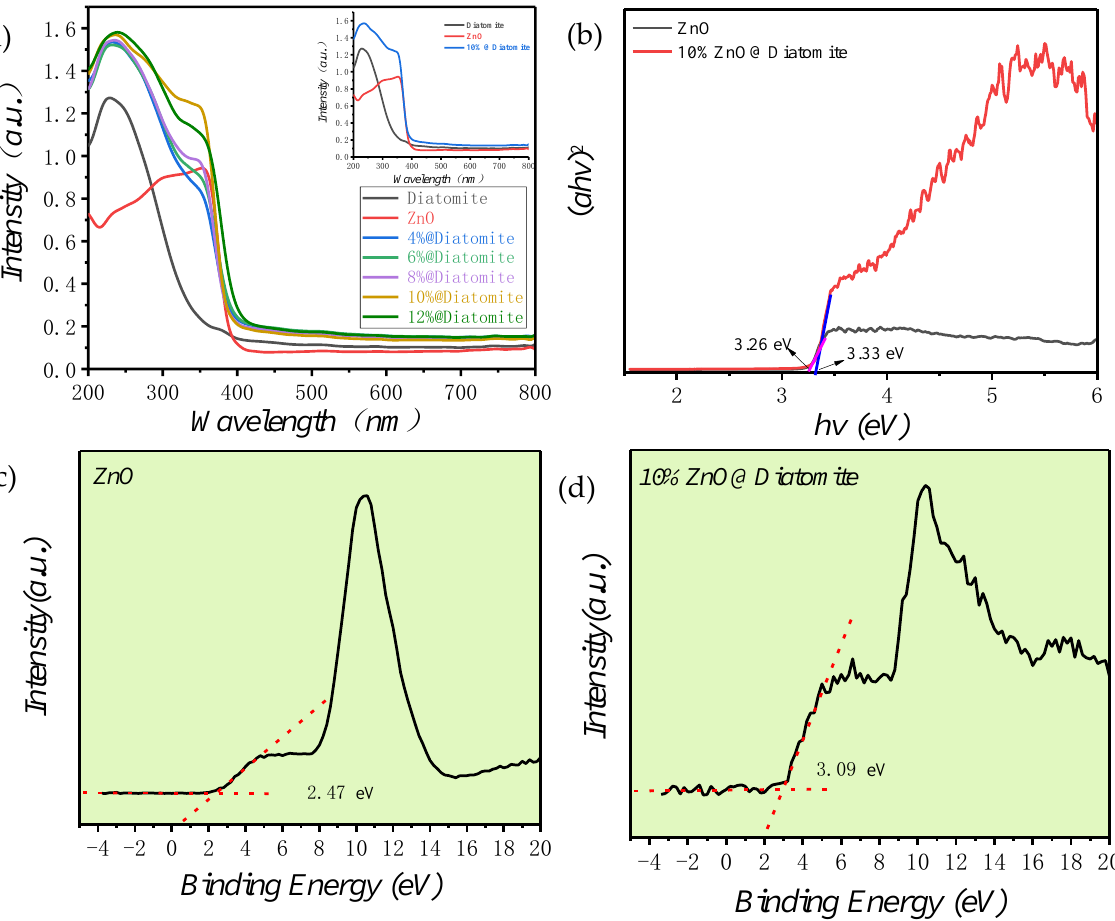
Figure 7. ( a )UV-vis spectra of X% ZnO@diatomite, ( b )plots of ( αhν ) 2 versus ( hν ), ( c )XPS valence band Figure 7. ( a ) UV-vis spectra of X%ZnO@diatomite, ( b ) plots of ( α h ν ) 2 versus (h ν ), ( c ) XPS valence band spectra of pure spectra of pure ZnO, ( d )XPS valence band spectra of 10% ZnO@diatomite. ZnO, ( d ) XPS valence band spectra of 10%